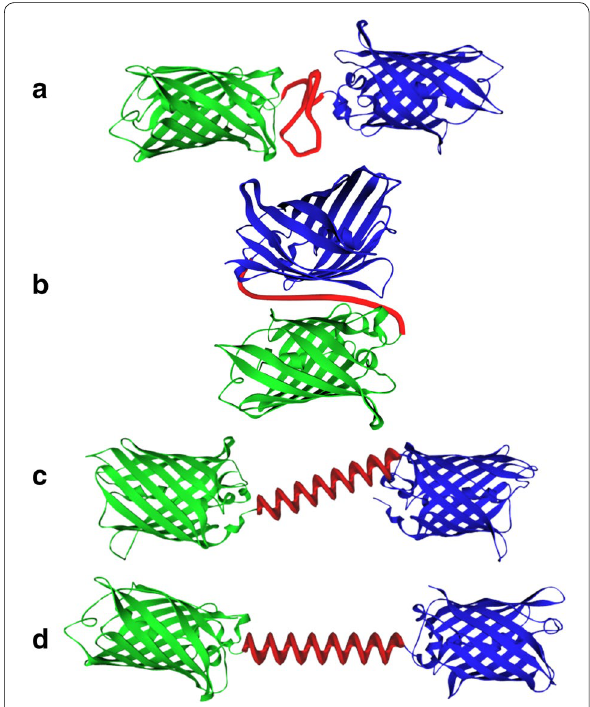
Fig. 28 Schematic illustrations of various conformations of the fusion proteins. a EBFP ( blue ) and EGFP ( green ) are situated in a straight line, with the flexible linker ( red ) between the two domains. b EBFP and EGFP reside side by side, for the most compact conformation with the flexible linker. c The helical linker connects EBFP and EGFP diagonally. d The helical linker and the long axes of EBFP and EGFP are situated in a straight line (Figure adapted with permission from: Ref. [347]. Copyright (2004) John Wiley &